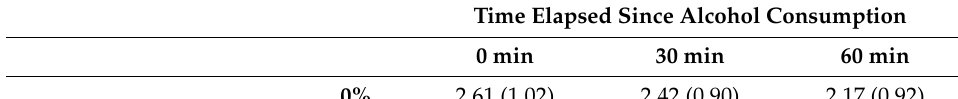
Table 2. The means (standard deviation) of self-report scores for intoxication under each alcohol concentration over